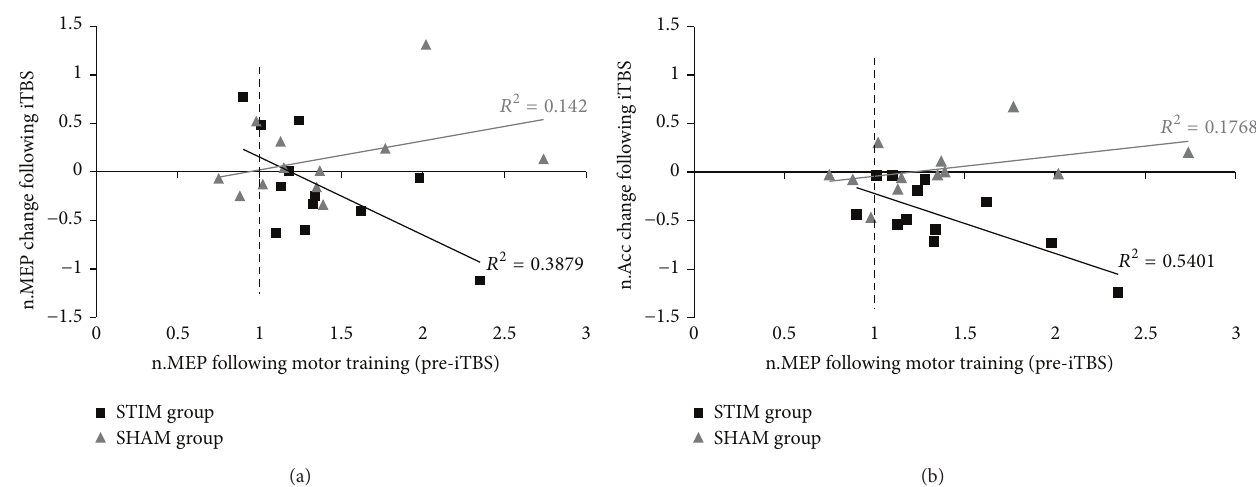
Figure 2: Individual participants’ responses to iTBS as a function of normalized MEPs (n.MEP) of the FDI muscle following motor learning (pre-iTBS)forSTIMgroup(blackrectangles)andSHAMgroup(greytriangles).(a)ChangesinnormalizedMEPsfollowingiTBS.(b)Changes in normalized acceleration (n.Acc) following iTBS. Relations between measures are displayed by linear trend lines and 𝑅 2 values for STIM (black) and SHAM group participants (grey). Vertical dashed lines represent MEP values at